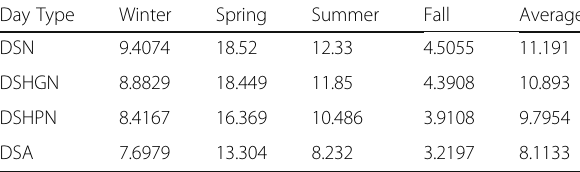
Table 2 Mape results comparison of different methods